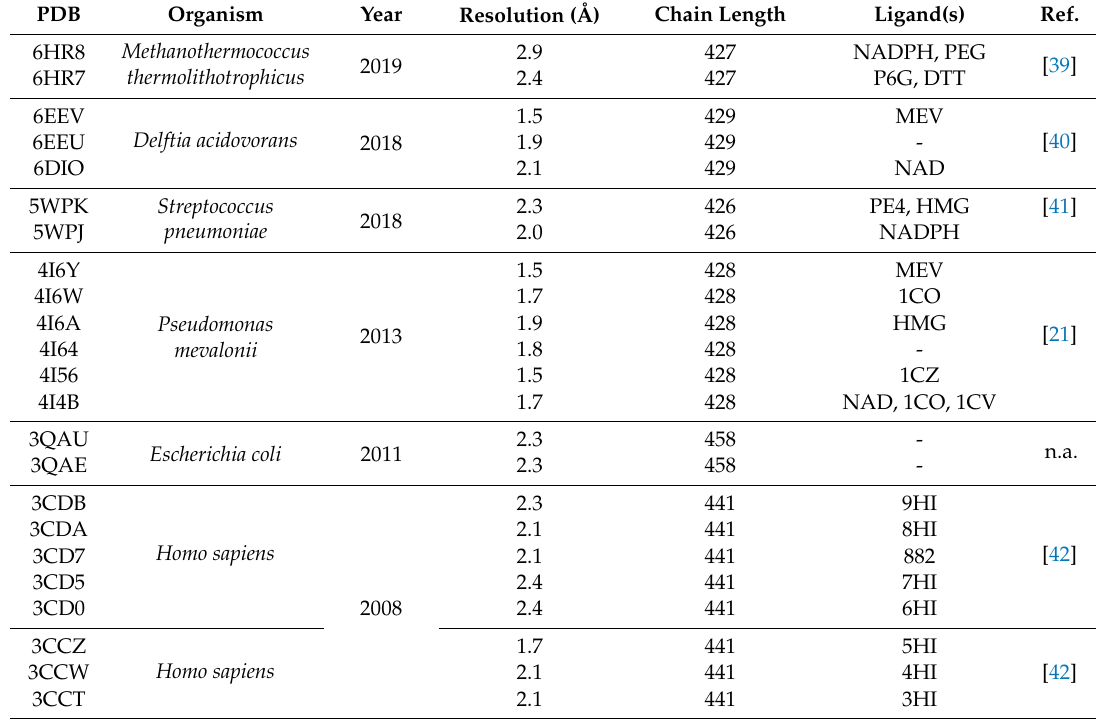
Figure 6. Structure of the tetramer and respective dimer of the human HMGCR, showing both CoA and NADPH (PDB entry 1DQA); chains are colored according with the letters: chain A is in magenta, chain B in blue, chain C in light green and chain D in orange. Table 1. Currently known HMGCR crystal structures available in the Protein Data Bank, organized chronologically, starting with the most recently available.